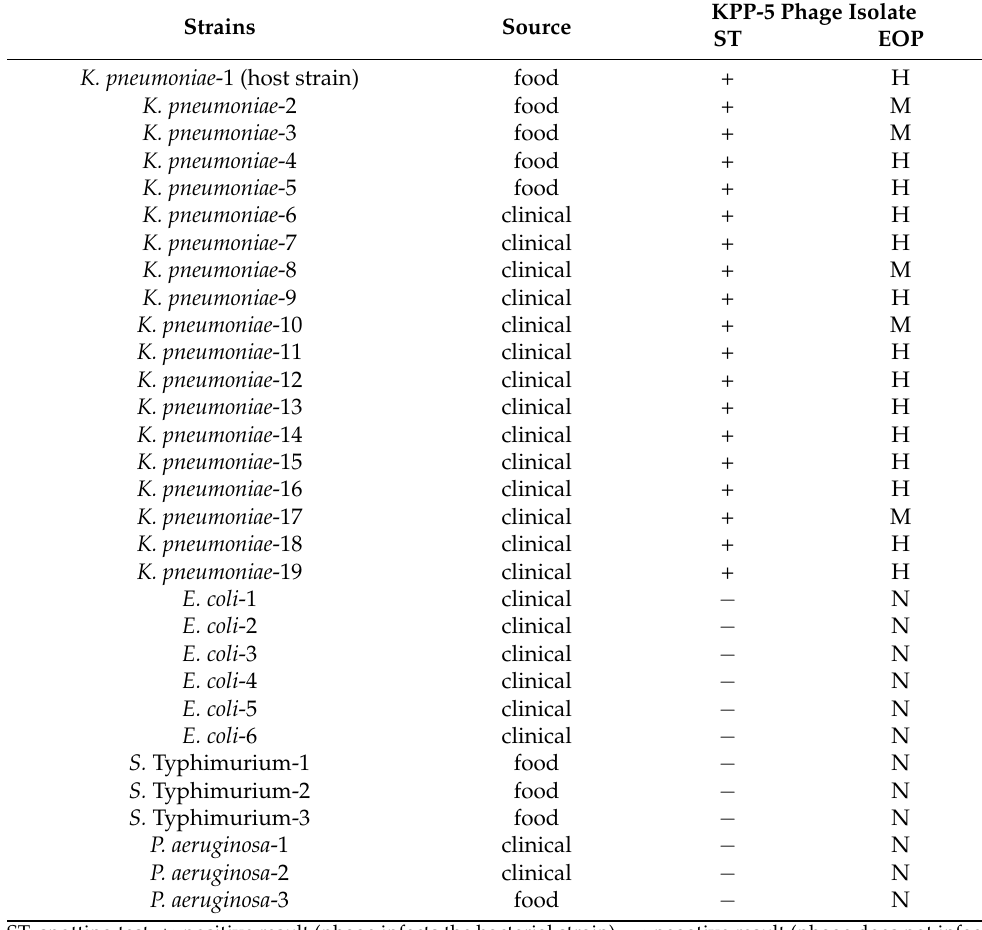
Figure 1. Plaques morphology (clear dots look like, small plaques, 1–1.5 mm diameter) formed by KPP-5 phage using overlay agar plate with Klebsiella pneumoniae lawn ( A ). Transmission electron micrograph image of K . pneumoniae KPP-5 phage podovirus morphology ( B ). Table 1. KPP-5 phage host range spectrum and EOP